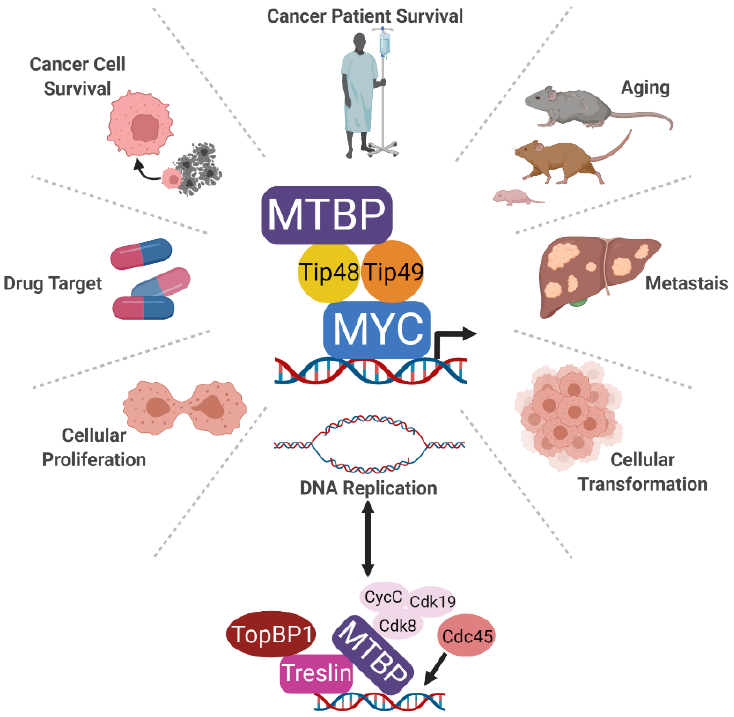
Figure 1. Schematic of the identified MTPB complexes and the cellular processes for which MTBP function has been associated. MTBP forms a complex with MYC at MYC-bound promoters via a direct interaction with Tip48 and Tip49. Research has linked MTBP to DNA replication, proliferation, cellular transformation, cancer cell survival, and metastasis as well as aging. While all of these functions can be linked back to MYC, MTBP additionally forms a complex with Treslin to promote the recruitment of Cdc45, enabling DNA replication origin firing. Similar to MYC, these collective oncogenic activities make MTBP an important potential cancer drug target.